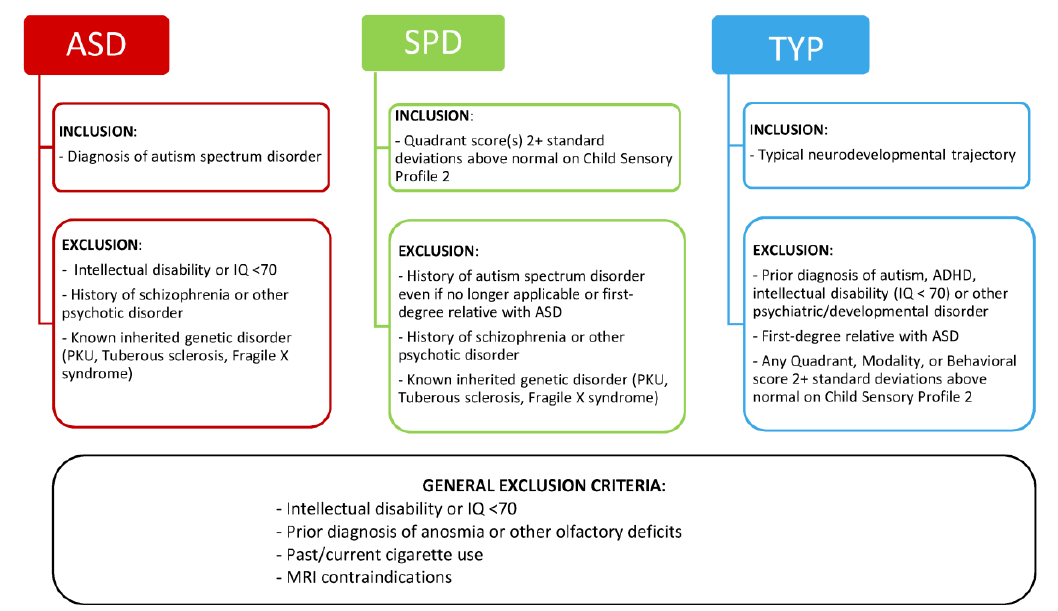
Figure 1. Eligibility and exclusion criteria for the three study groups. ASD = children with Autism Spectrum Disorder; SPD = children with demonstrated Sensory Processing Dysfunction; TYP = Typically Developing children.